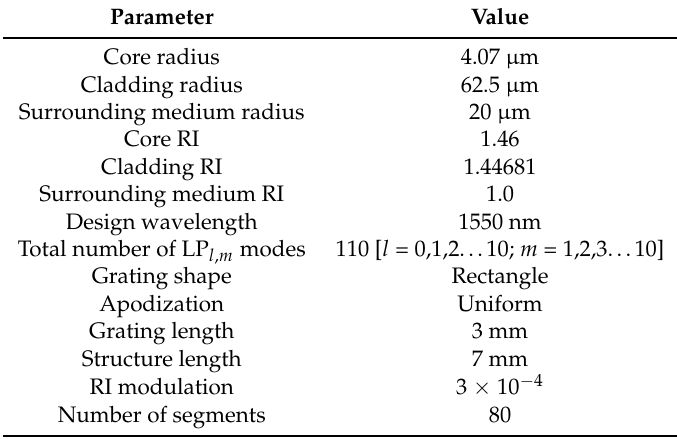
Table 1. Simulation parameters.